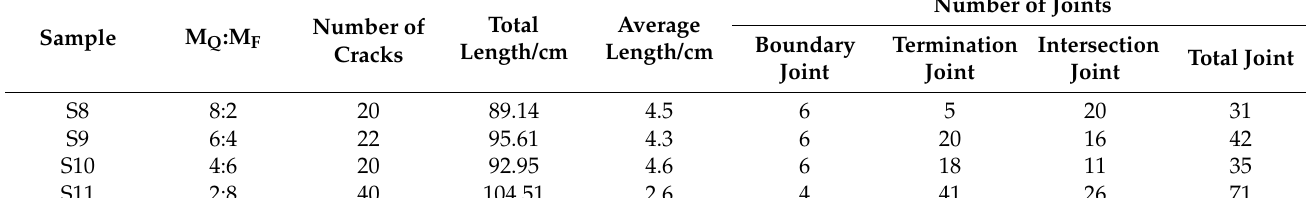
Table 7. Morphological parameters of samples with different values of M Q :M F .